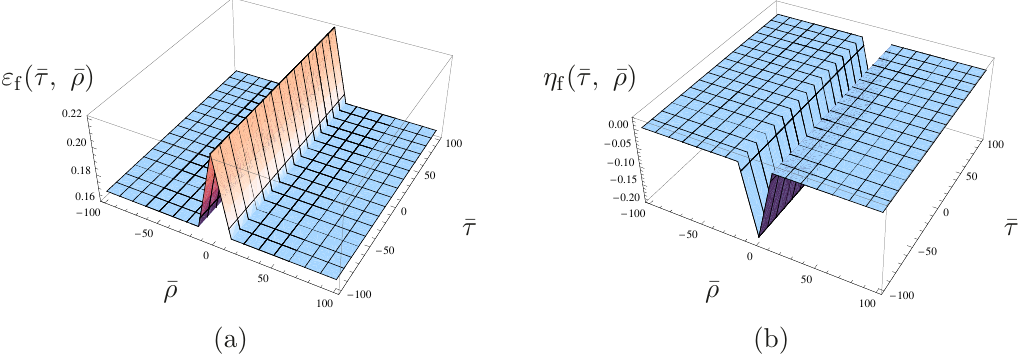
Figure 8 . We show the parameters ε f (¯ τ, ¯ ρ ), and η f (¯ τ, ¯ ρ ), numerically for the type IIB theory. Our parameters are R (Y) = 0, A H = A p = A D p = 0, and A O p and κ = 1, in the moduli potential (2.12). It shows that our setup does not satisfy the fast-roll condition